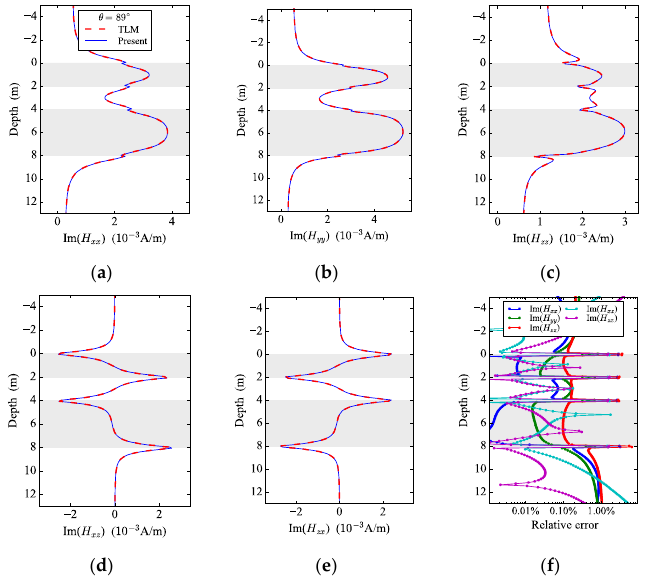
Figure 10. Responses of the tool with dip angle θ = 89 ◦ simulated by the TLM and present method. ( a ) Im ( H xx ) . ( b ) Im ( H yy ) . ( c ) Im ( H zz ) . ( d ) Im ( H xz ) . ( e ) Im ( H zx ) . ( f ). Relative error.